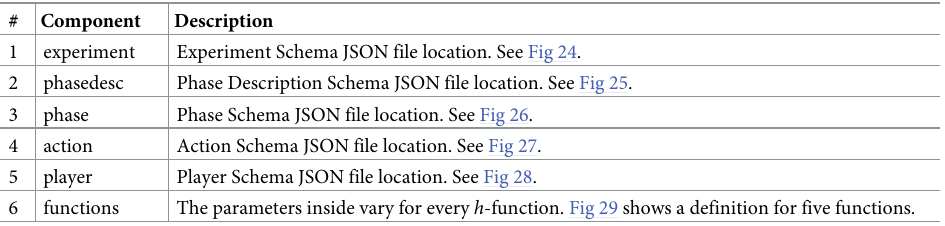
Table 6. Configuration input file description.